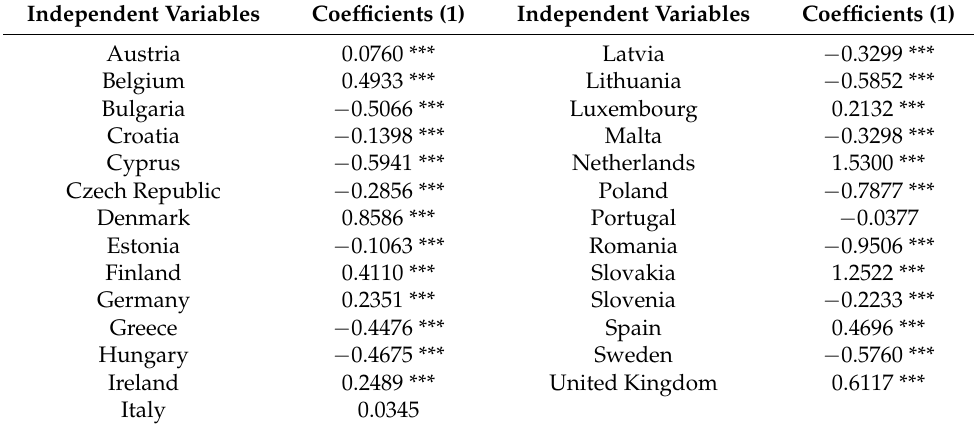
Table 3. Weighted coefficient estimates for selection equation